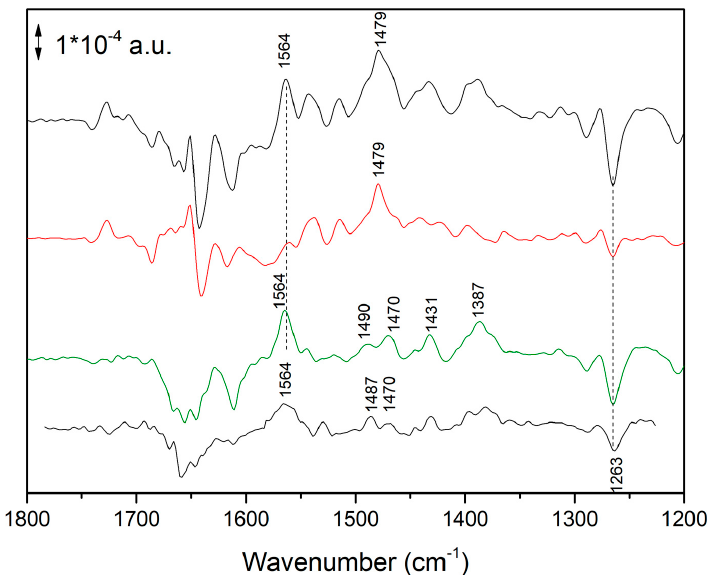
Figure 5. FTIR difference spectra recorded after one (red trace—2nd from top) and two flashes (black trace—1st from top). The difference spectrum after 2 flashes represents a mixture of ~75% QH 2 state and of 25% Q B − state [6]. The third trace from the top (green) was obtained by subtracting (multiplied by a 0.3 coefficient) a Q B − /Q B difference spectrum (red—2nd trace from the top) from the difference spectrum obtained after two flashes (black—1st trace from the top). This third trace represents the species formed after a double reduction of Q B and shows an intense positive 1564 cm − 1 band. The fourth trace from the top (black) was taken from [15], obtained after a chemometric analysis of time-resolved FTIR difference spectra of isolated RCs under and after continuous illumination, where four spectral contributions were identified. The plotted trace—characterized by a strong positive peak at 1564 cm − 1 —is believed to represent a double-reduced form of Q [15]. The last trace from the top (black) was reprinted by permission from Ref. [15], Copyright 2011, Springer..